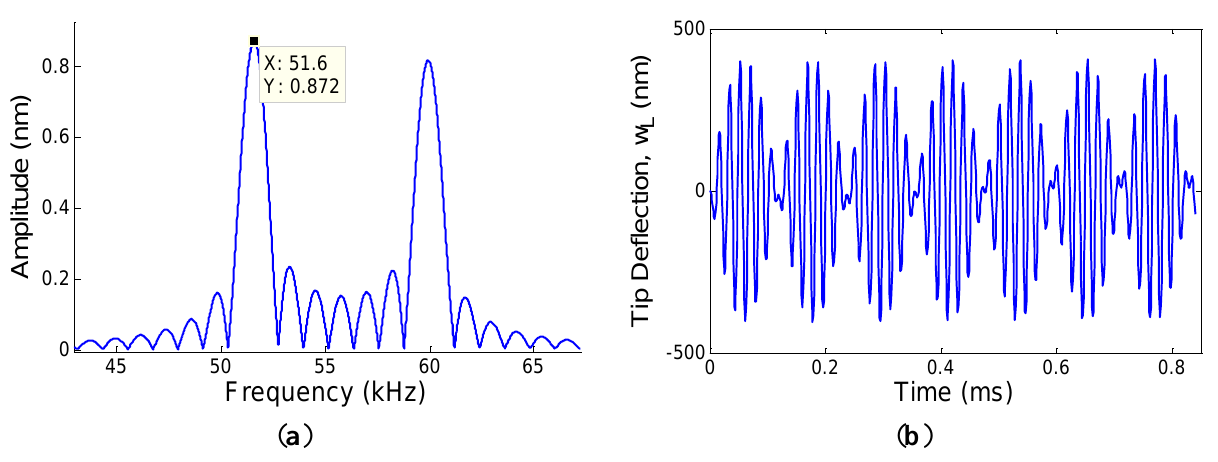
( x , t ), ( b ) FFT response of the system with 1st L